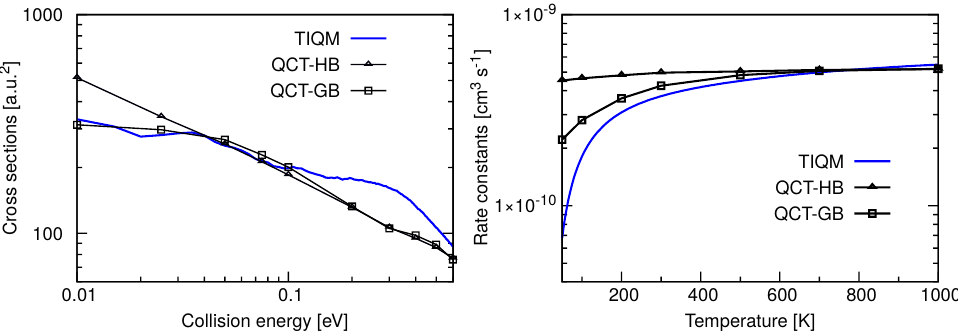
Figure 18. Total integral cross sections as a function of collision energy ( left panel ) and rate con- stants as a function of temperature ( right panel ) for the Ar + ArH + ( v = 0, j = 0 ) → ArH + + Ar calculated following TIQM (solid blue line) and QCT (QCT-HB: green line+symbols, QCT-GB: black line+symbols) methods. Data are taken from Ref.